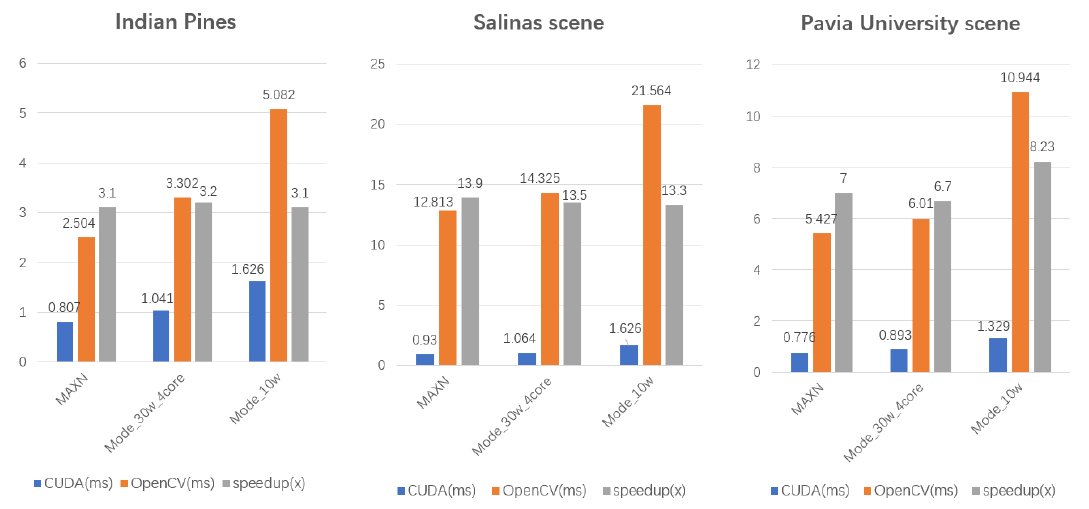
Figure 10. Run times of INAPC for the three datasets at three different working mode on NVIDIA Jetson Xavier.